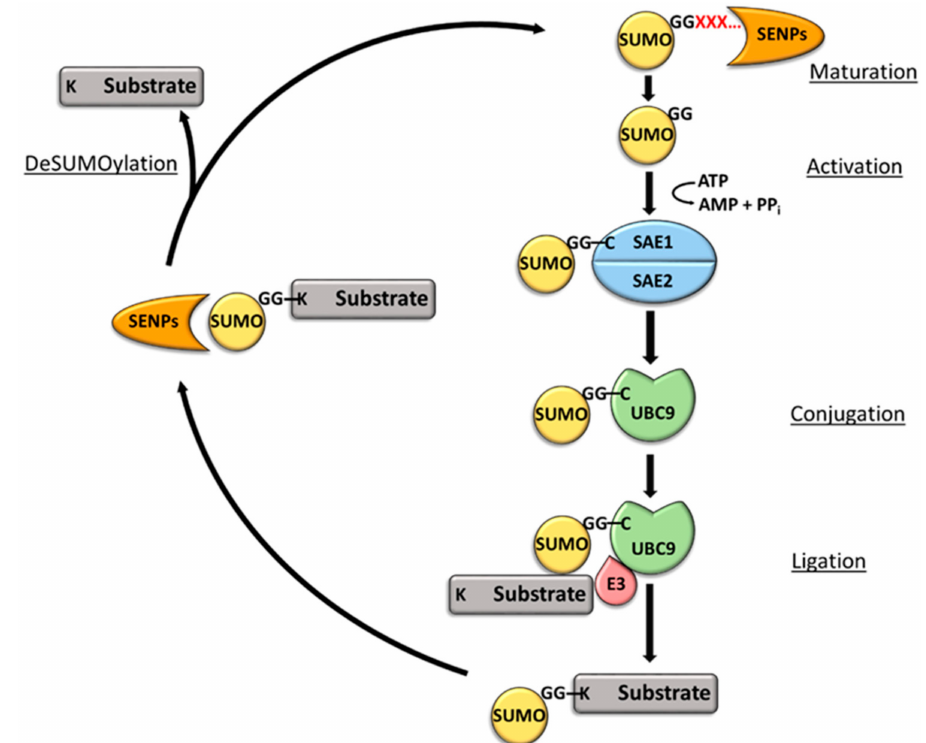
Figure 3. The SUMOylation catalytic cycle. SENP family protease removes C-terminal amino acids of the SUMO precursor. The mature SUMO is activated in the ATP-dependent formation of a thioester bond with the SAE2 subunit of the E1 activating enzyme. SUMO is transferred to the E2 conjugating enzyme, UBC9, by a trans-thiolation reaction. An E3 ligase facilitates the ligation of SUMO to the substrate by binding to both UBC9 and the substrate. SUMOylation is reversed when a protease from the SENP family cleaves the SUMO